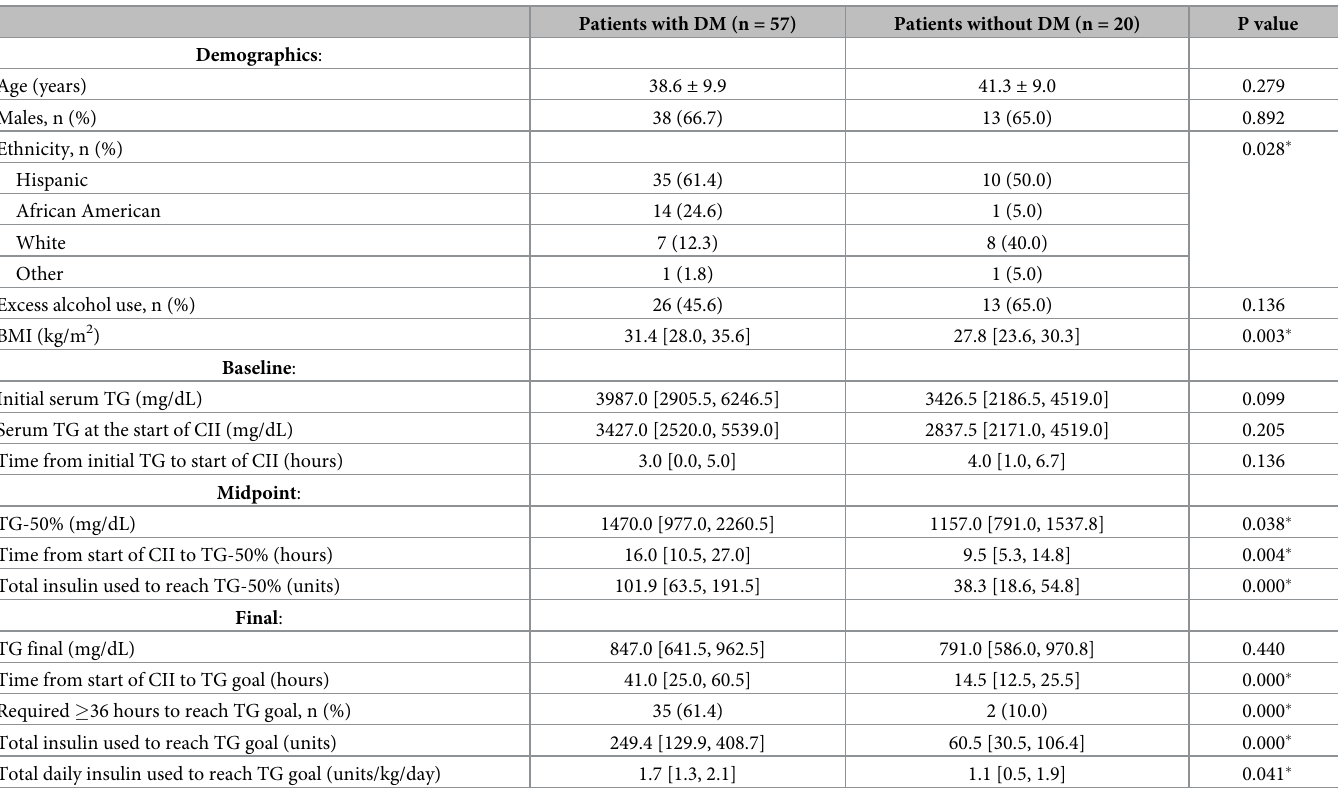
Table 3. Differences between patients with and without diabetes.